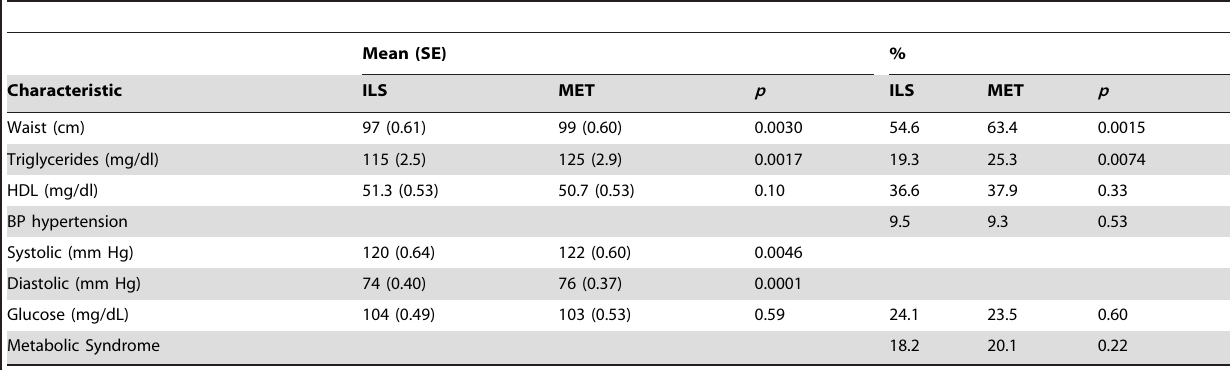
Table 1. Differences between the DPP intensive lifestyle (ILS, n =571) versus metformin (MET, n =557) treated patients at three years of follow-up with respect to quantitative trait components of the metabolic syndrome, and binary indicators of abnormal levels, and the overall incidence of the metabolic syndrome among those free of the syndrome on entry.